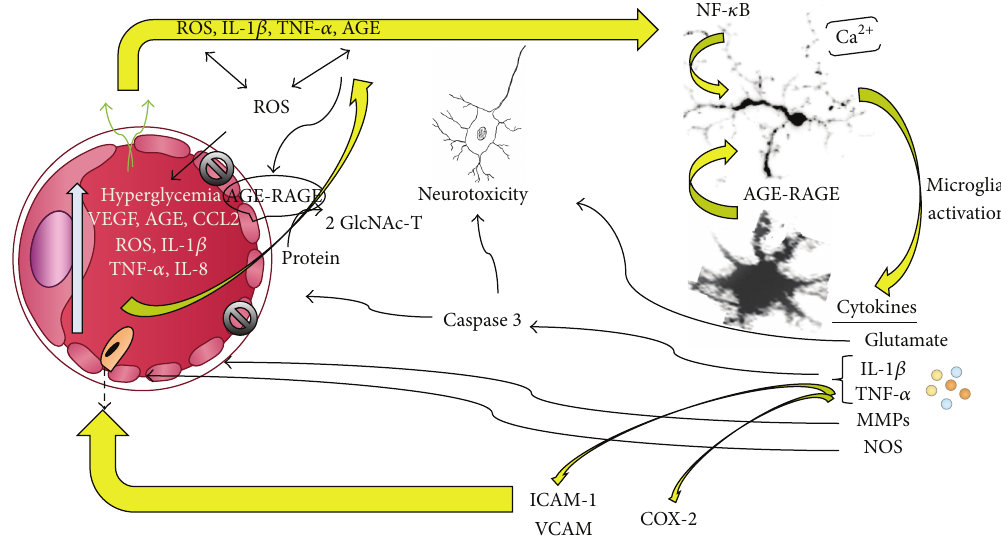
Figure 1: Inflammation during diabetic retinopathy. Increased plasma levels of blood glucose, vascular endothelial growth factor (VEGF), advanced glycation end-products (AGE), reactive oxygen species (ROS), chemokine (C-C motif) ligand 2 (CCL2), interleukins 1 beta and 8 (IL-1 𝛽 and IL-8), and tumor necrosis factor alpha (TNF- 𝛼 ) profuse through leaky capillary endothelial cell junctions by the actions of VEGF. IL-1 𝛽 , AGE, ROS, and TNF- 𝛼 activate microglia to produce glutamate, matrix metalloproteinases (MMPs), nitric oxide synthases (NOS), IL-1 𝛽 , and TNF- 𝛼 . IL-1 𝛽 and TNF- 𝛼 drive the production of caspase 3, which along with glutamate is neurotoxic to retinal ganglion cells. Caspases also damage capillary endothelial cells and pericytes. TNF- 𝛼 leads to production of ICAM-1 and VCAM that help recruit macrophages through the capillary walls sustaining a chronic inflammatory response. COX-2 is also a product stimulated by IL-1 𝛽 and TNF- 𝛼